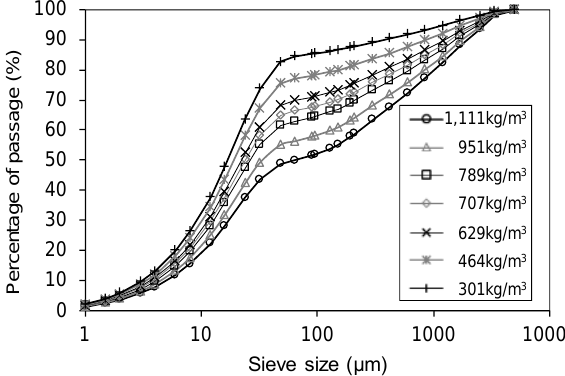
Figure 22. Size distributions of materials without steel fibres.